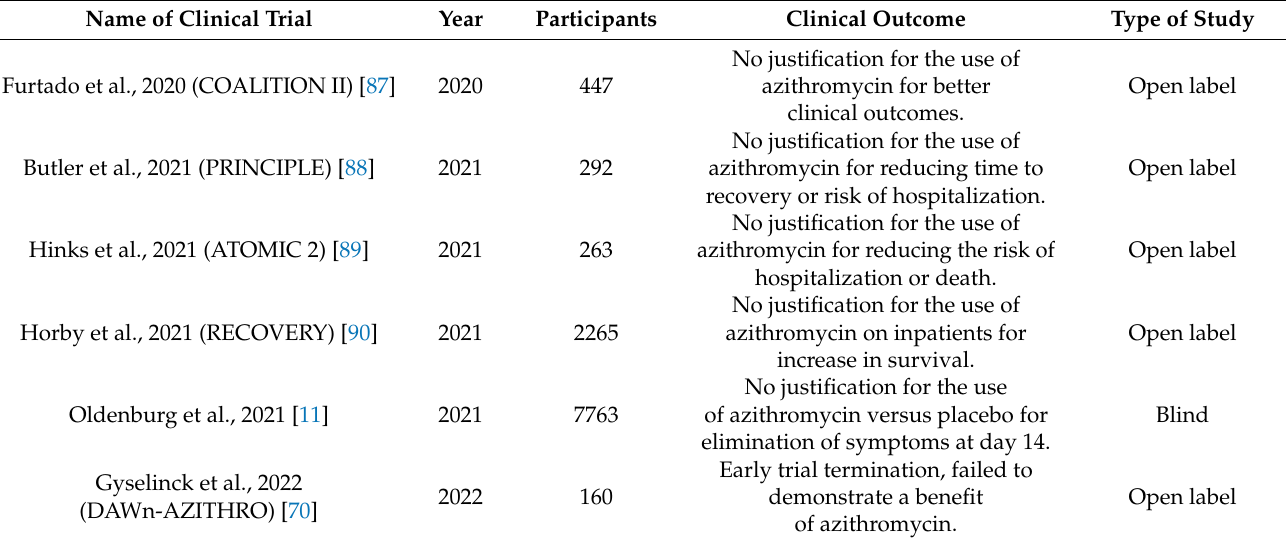
Table 1. Published RCTs assessing the effect of Azithromycin on COVID-19